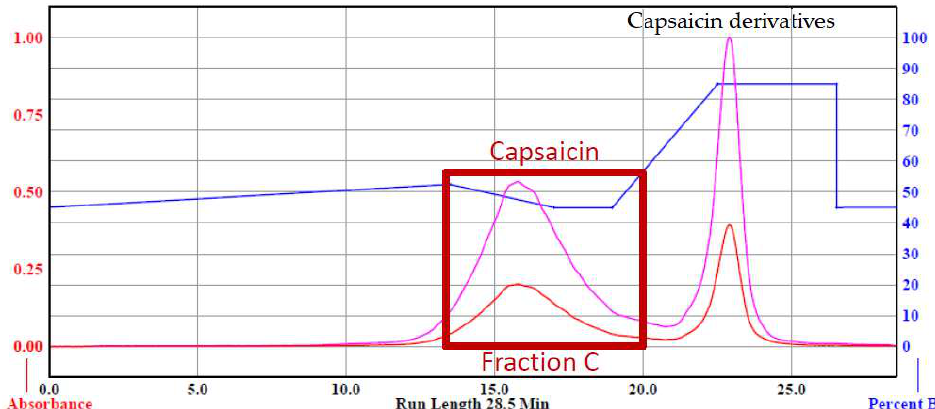
Figure 7. Chromatogram of capsaicins showing the separation of capsaicin (Fraction C) from other capsaicin derivatives. The blue line indicates the percentage of ethanol in the aqueous mobile phase. The pink and red lines indicate the UV absorptions at 228 nm (for detection) and 300 nm (for monitoring), respectively.